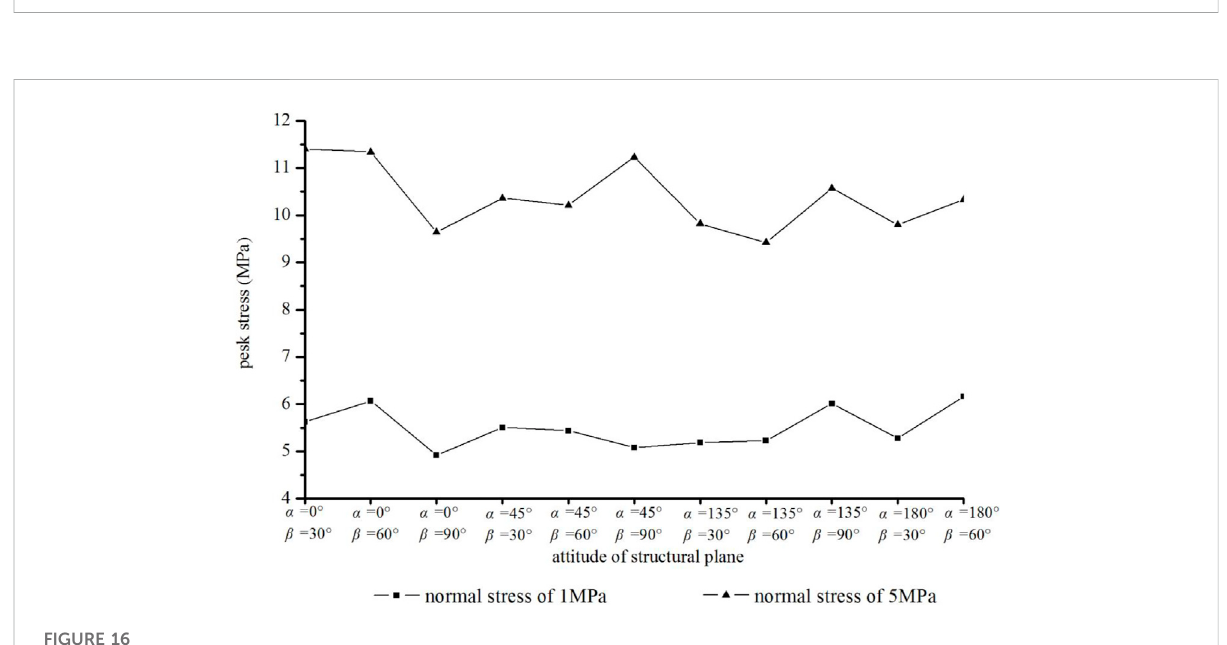
FIGURE 15 Relationship curve of crack initiation shear stress versus attitude of crack.